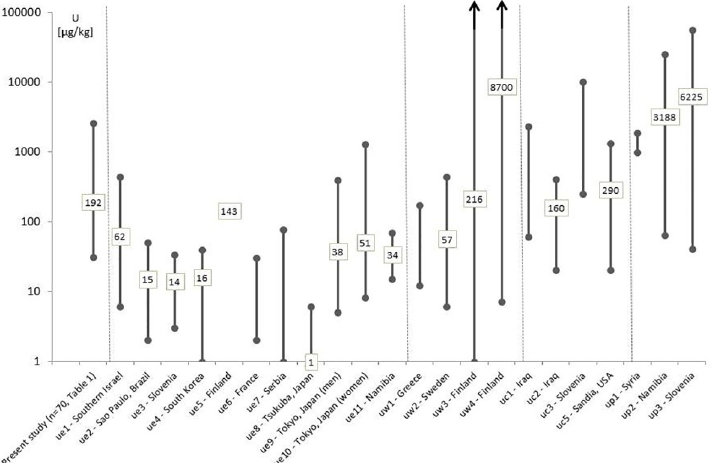
Fig 1. Uranium (U) concentrations in μ g/kg measured in all composite hair samples and in high-exposure (HE) and low-exposure (LE) wards (as shown in Table 1) combined of the present study in Gauteng Province, South Africa, compared with international measurements of U concentrations in presumably unexposed populations (ue), populations with expected higher U in drinking water (uw), populations exposed to U contamination from nuclear facilities or depleted U in war zones (uc), or populations affected by mining or U production (up) (shown as means and ranges). Three-letter code in the study name indicates the study ID from S1 Table for reference.